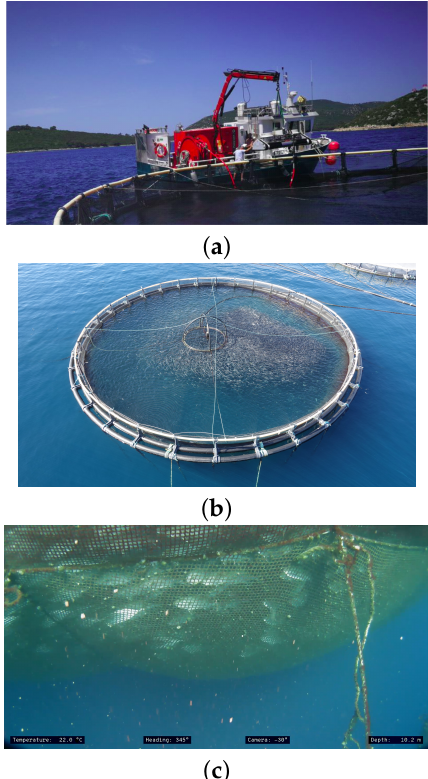
Figure 5. ( a ) Commercial, manually controlled machine for undersea net cleaning. ( b ) Image taken from inspection LAAR flying above the net pen. ( c ) Undersea images of net pens taken by an inspection